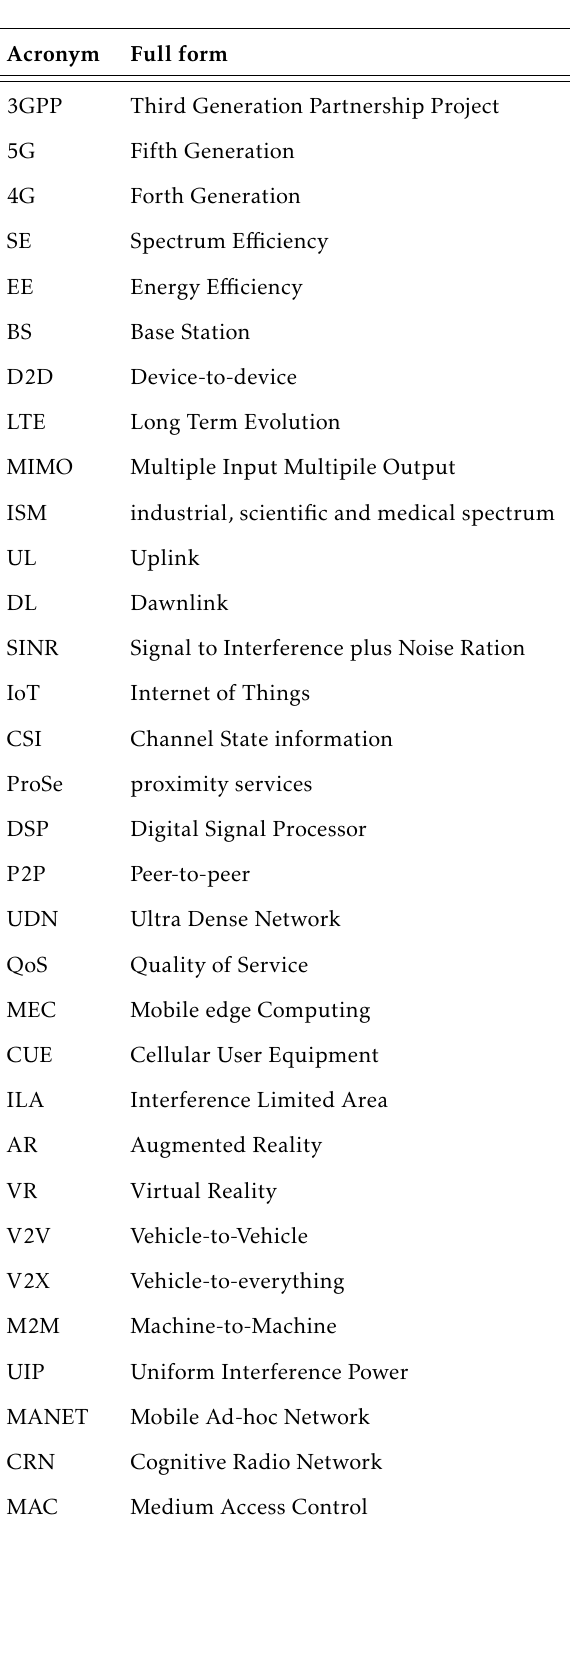
Table 1. List of Acronyms.